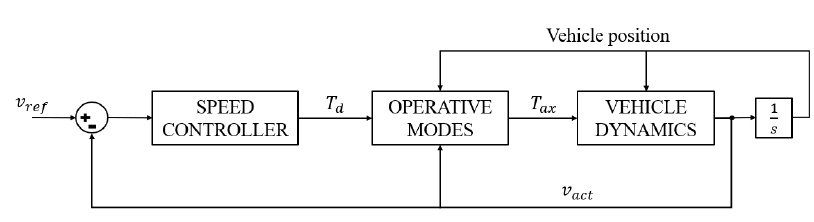
Figure 8. Block model structure of the vehicle dynamics and control loop.